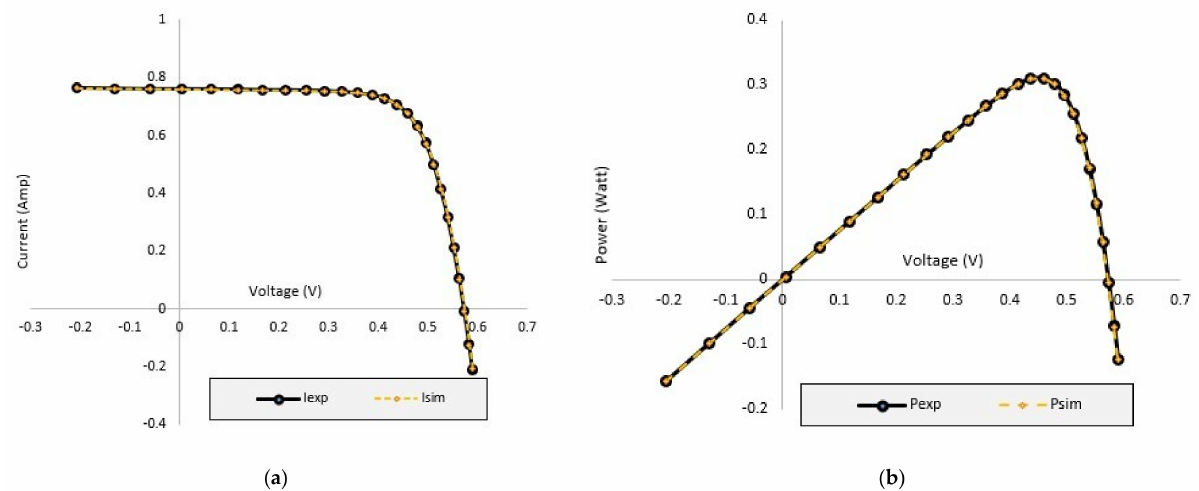
Figure 6. Characteristic curves for R.T.C. France SDM based on parameters extracted from TFWO: ( a ) Current–voltage (I–V) ch/s and ( b ) power–voltage (P–V) ch/s.